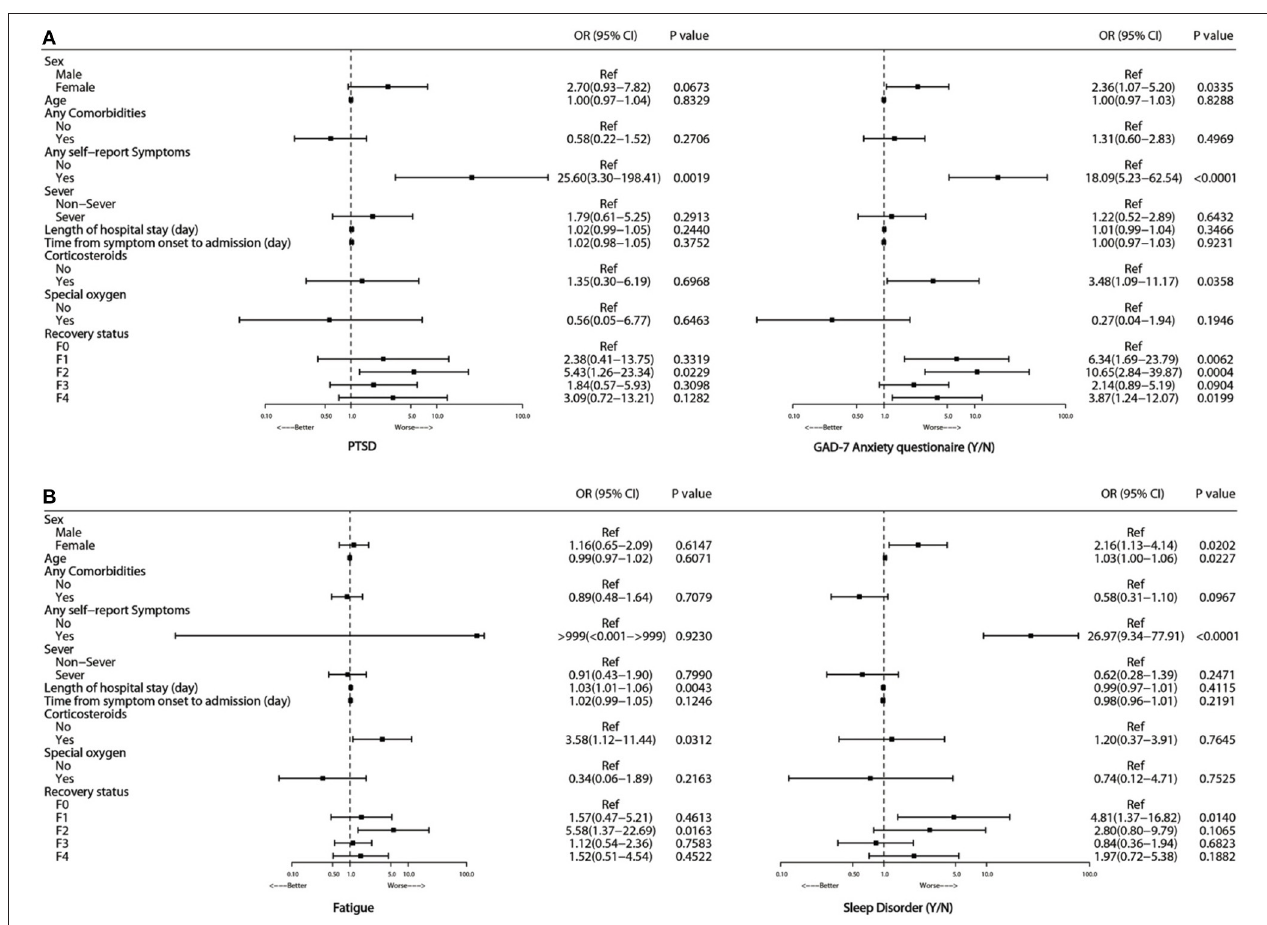
FIGURE 2 | Risk factors associated with PTSD and GAD-7 anxiety (A) , fatigue and sleep disorder (B) at 15-month